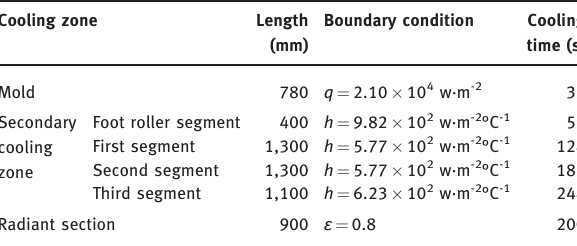
Table 3: Cooling intensity and operation time of each cooling zone. Cooling zone